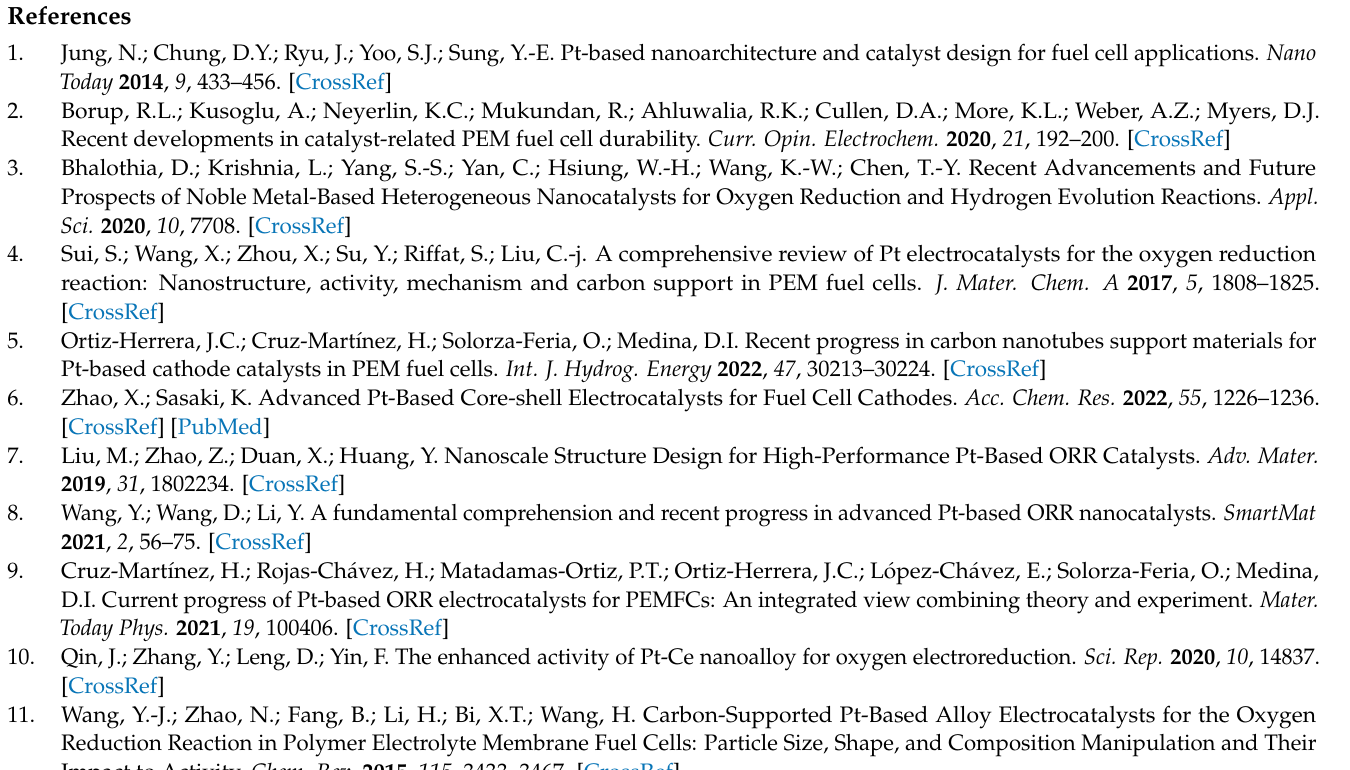
Figure S2: X-ray diffraction patterns of control samples. All the spectra were measured under the incident X-rays of 18 keV; Figure S3: Electrochemical results of CSPP NCs. (a) LSV, (b) Onset potential (Voc)/half wave potential (E 1/2 ), (c) kinetic current density and (d) ORR mass activity of CSPP